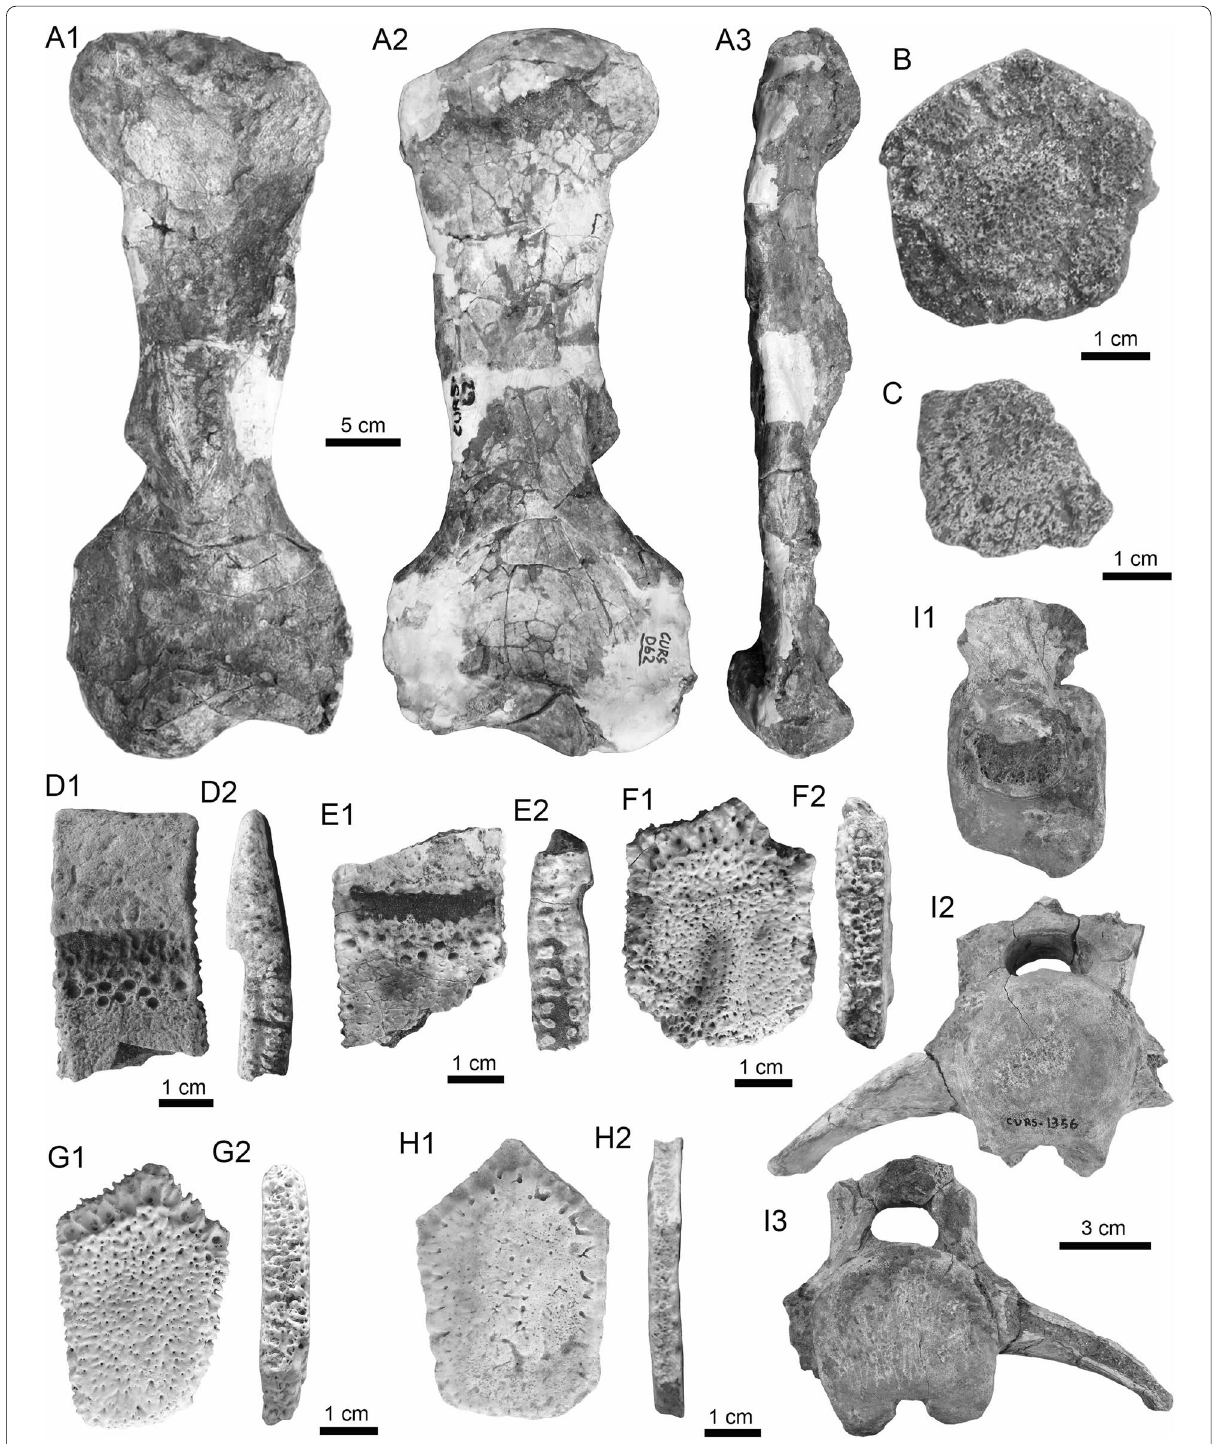
Fig. 23 Xenarthra (Mylodontidae, Glyptodontidae, and Pampatheriidae) from the Vergel ( A1 – E2 , H1 , H2 ) and Cocuiza ( F1 – G2 , I1 – I3 ) members. A1 – A3 Right humerus (AMU‑CURS‑62) of Mylodontidae indet. B , C Carapace osteoderms (AMU‑CURS‑1242) of dorsal or postero‑dorsal ( B ) and indeterminate position ( C ) of aff. Boreostemma sp. D1 – G2 Movable osteoderms ( D1 , D2 AMU‑CURS‑1063, and E1 , E2 AMU‑CURS‑1119), and fixed osteoderms of pelvic buckler ( F1 , F2 AMU‑CURS‑1295, and G1 , G2 AMU‑CURS‑1294) of aff. Holmesina floridanus . H1 , H2 Fixed osteoderm of pelvic buckler (AMU‑CURS‑736) of aff. Plaina sp. I1 – I3 Incomplete caudal vertebra (AMU‑CURS‑1356) of Xenarthra indet. Views: anterior ( A1 , I2 ), cross sectional ( D2 , E2 , F2 , G2 , H2 ), external ( B – D1 , E1 , F1 , G1 , H1 ), left lateral ( I1 ), medial ( A3 ), and posterior ( A2 , I3